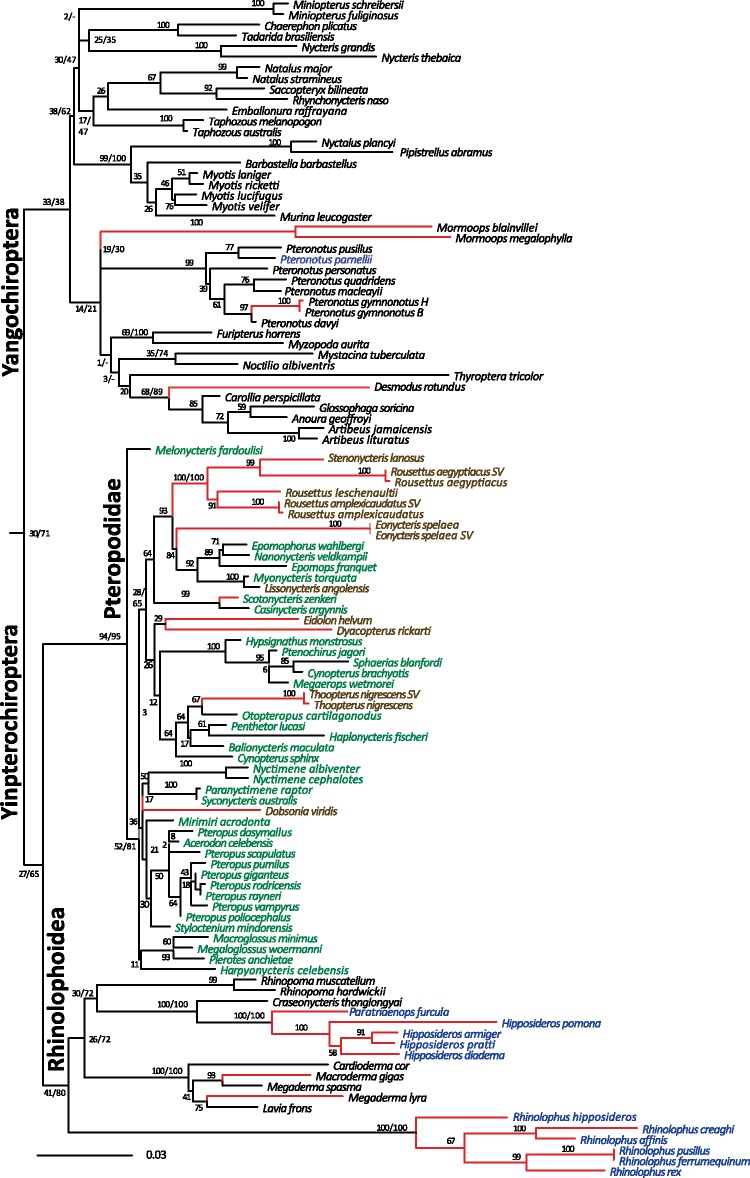
Phylogram inferred from ML analysis of the SWS1 opsin gene. Nodal support for both the ML and BA analysis are shown at nodes corresponding to major clades. Species using HDC echolocation are highlighted in blue. Red branches correspond to tips in which the SWS1 gene is nonfunctional. The Pteropodidae are highlighted in green, where brown is used to denote cave-dwelling taxa.